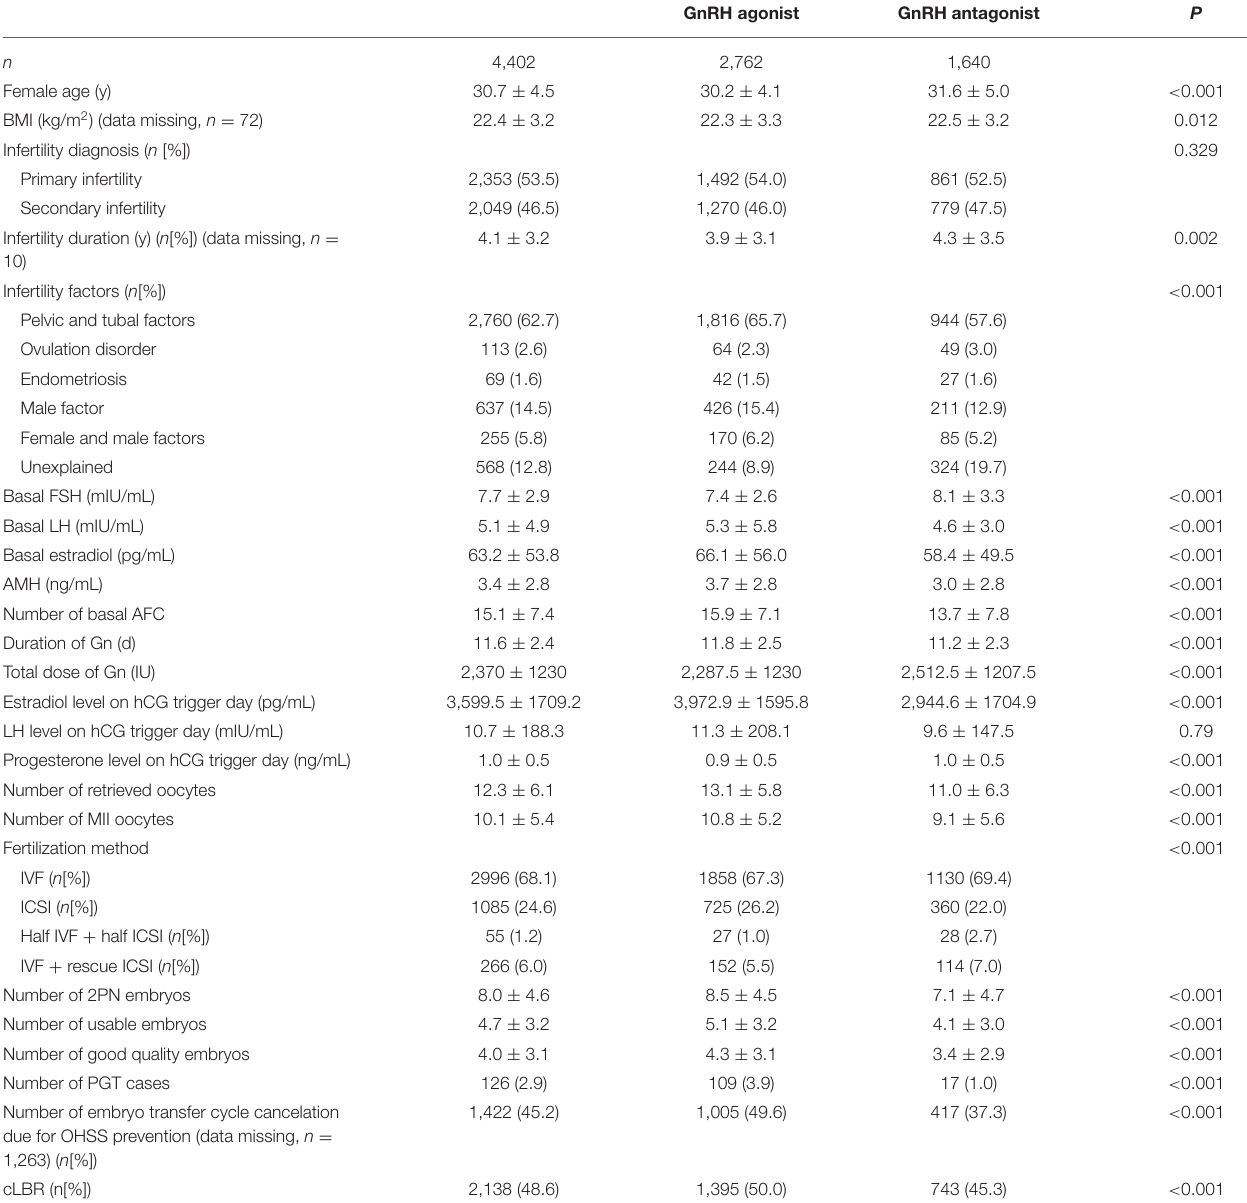
TABLE 1 | Demographic characteristics of the study population.